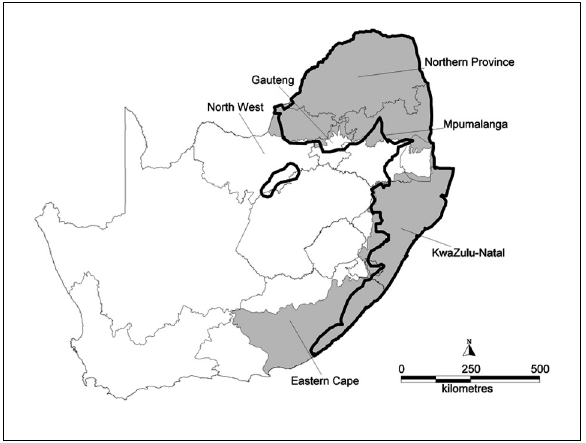
The areas of South Africa endemic for urinary schistosomiasis, as mapped by Porter 21 in 1938 (shaded area) and Gear et al. 22 in 1980 (area within the solid black